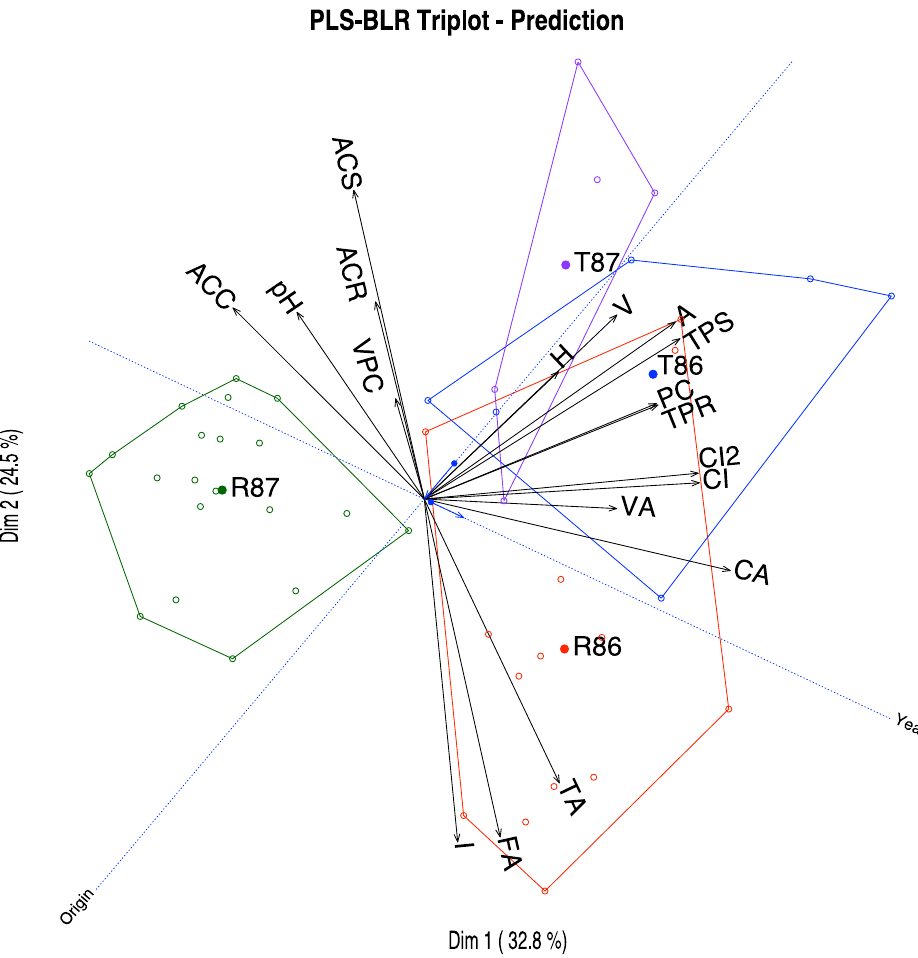
Figure 7. PLS-BLR Triplot for the wine data with groups represented as convex